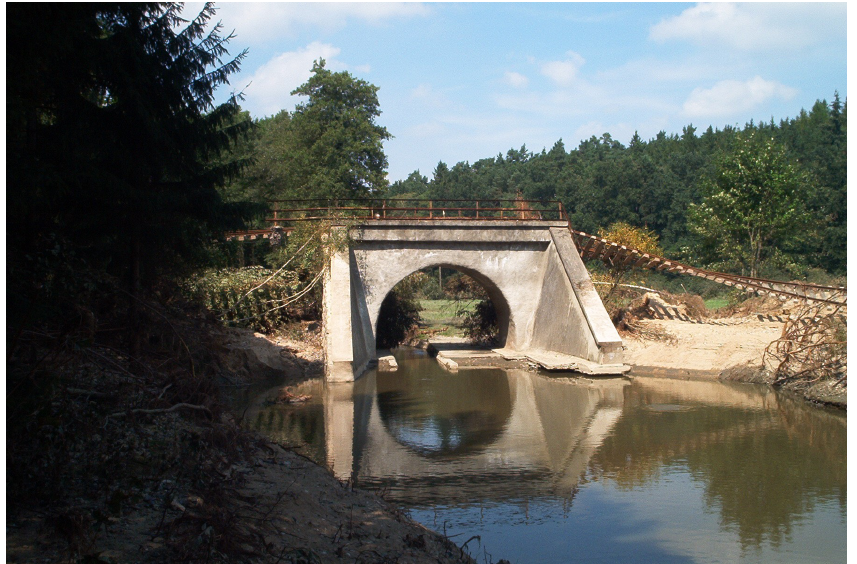
Figure 3. The erosion of Blatná – Nepomuk railway embankment. The water table shown on photo is typical for an ordinary flow